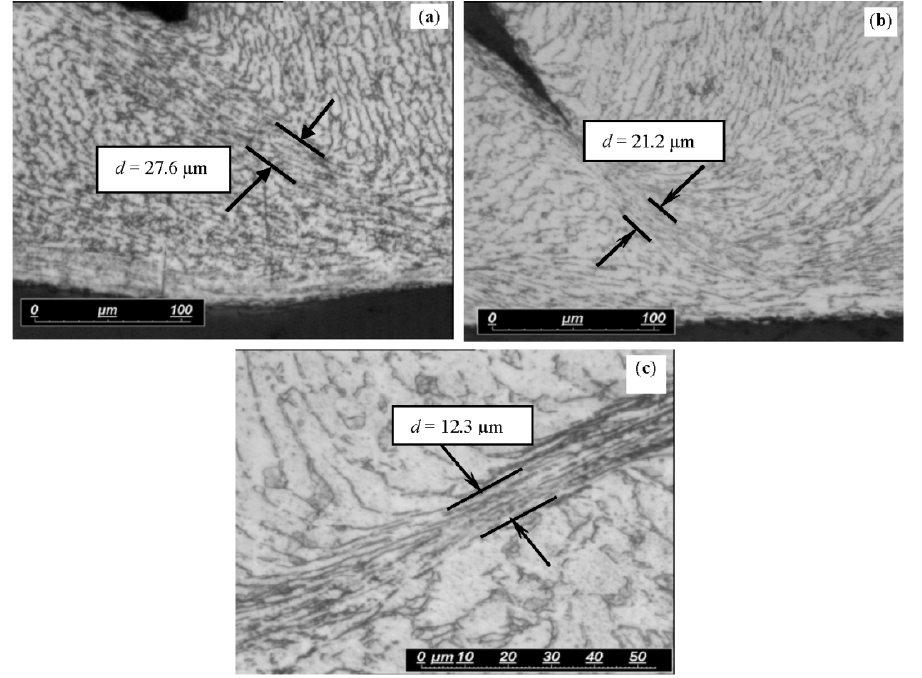
Figure 11. Evolution of the adiabatic shear band thickness depending on the cutting speed for Ti-6Al-4V. ( a ) 20 m/min, ( b ) 35 m/min, ( c ) 65 m/min. Tests without